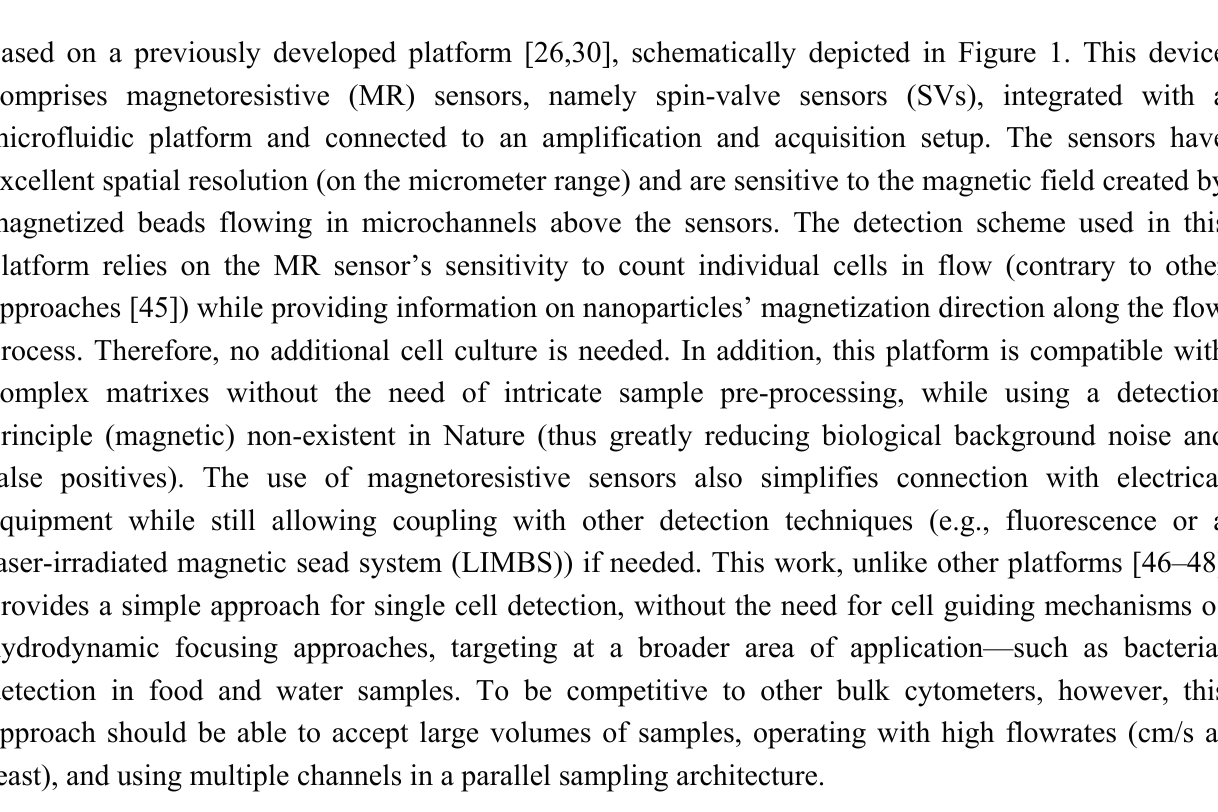
Figure 1. Schematics of magnetic detection device for identification and quantification of